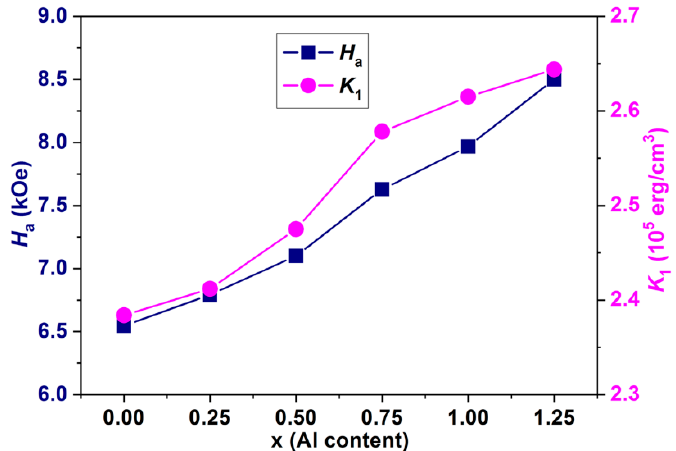
Figure 11. The impacts of Al content (x) on the first anisotropy constant ( K 1 ) and magnetic anisotropy field ( H a ) of the W-type SrYb hexaferrite Sr 0.85 Yb 0.15 Zn 1.5 Co 0.5 Al x Fe 16-x O 27 (0.00 ≤ x ≤ 1.25).